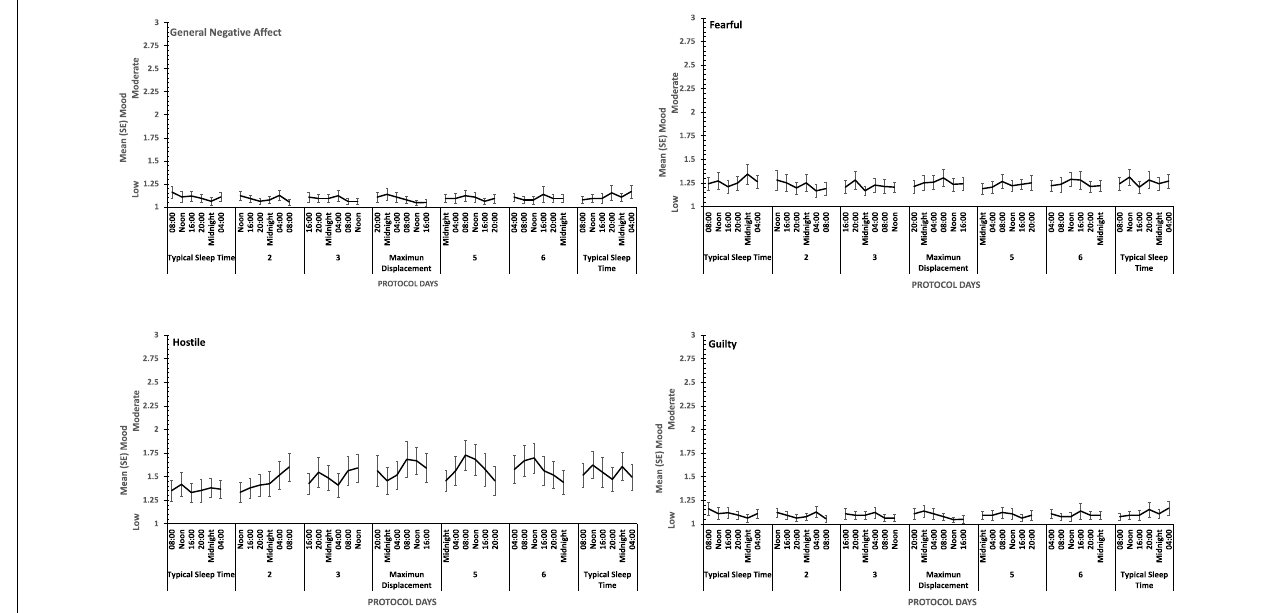
FIGURE 7 | Effects of circadian phase on Negative mood (General Negative Affect, Fearfulness, Guilt, Hostility) across a week-long 28 h Forced Desynchrony protocol.